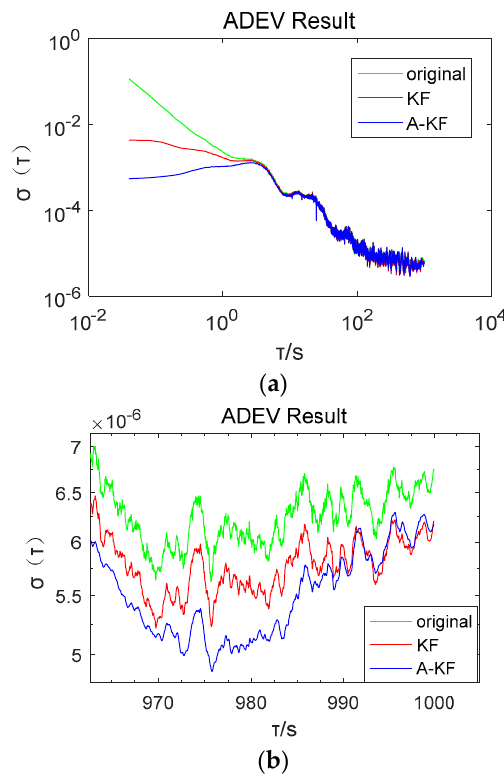
Figure 9. Long term Allan Deviation (ADEV) double logarithmic chart. ( a ) Entirety ADEV double logarithmic chart; ( b ) part of the long term ADEV chart zoomed in.